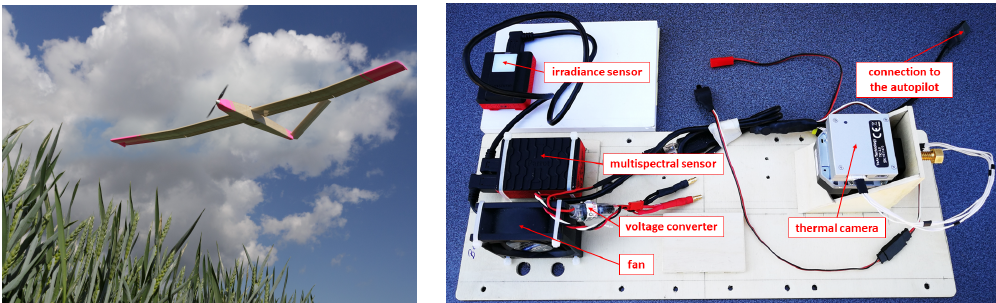
Figure 3. The fixed-wing UAV used during our thermal campaigns ( left ). The sensor platform of the UAV consists of a dual sensor system with a multispectral VNIR sensor, including an irradiance sensing element and a thermal camera ( right ). The LWIR camera is connected to the autopilot of the UAV to record GPS data and heading information, stored as metadata.